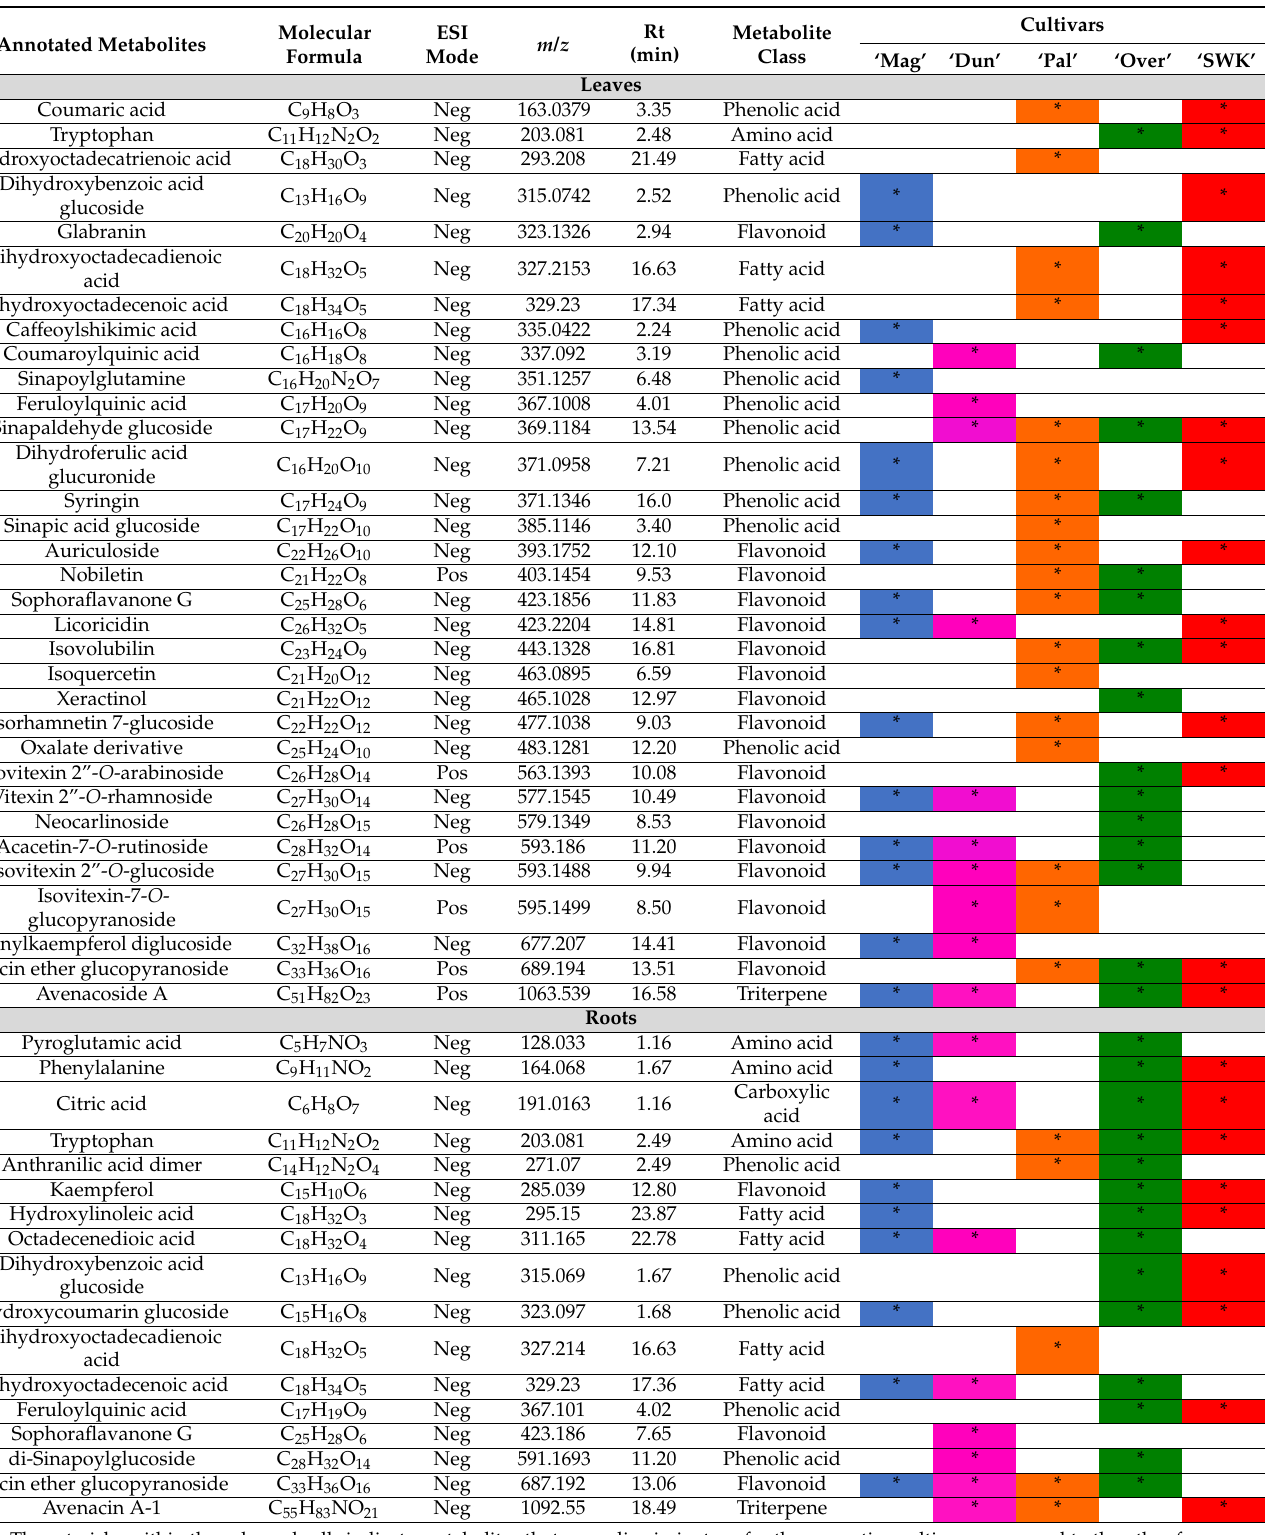
Table 1. List of key discriminatory metabolites putatively identified from leaves and roots of the oat cultivars ‘Magnifico’ (Mag), ‘Dunnart’ (Dun), ‘Pallinup’ (Pal), ‘Overberg’ (Over) and ‘SWK001’ (SWK). These metabolites were identified based on OPLS-DA S-plots, with a rigorous statistical validation. All metabolites had variable importance in projection (VIP) scores >